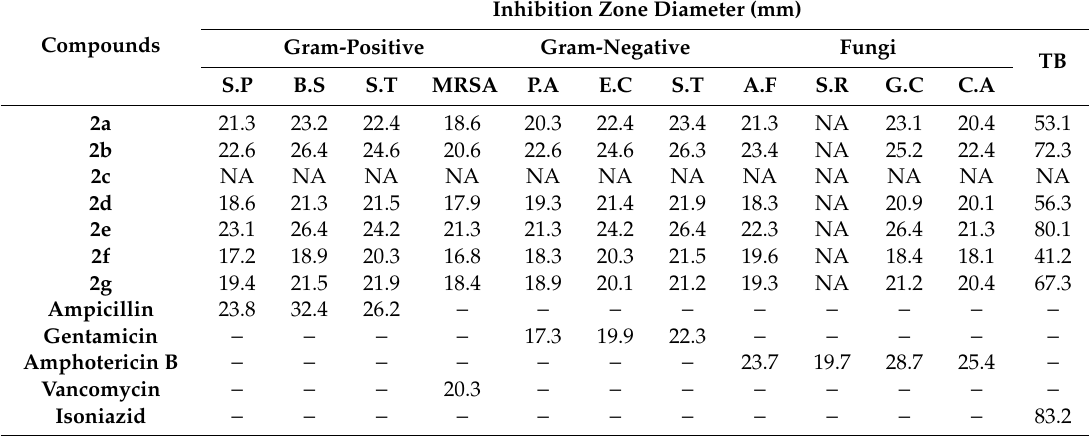
Table 5. Antimicrobial activity of the synthetic compounds (inhibition zone (IZ) diameter (mm)) (1 mg / mL).